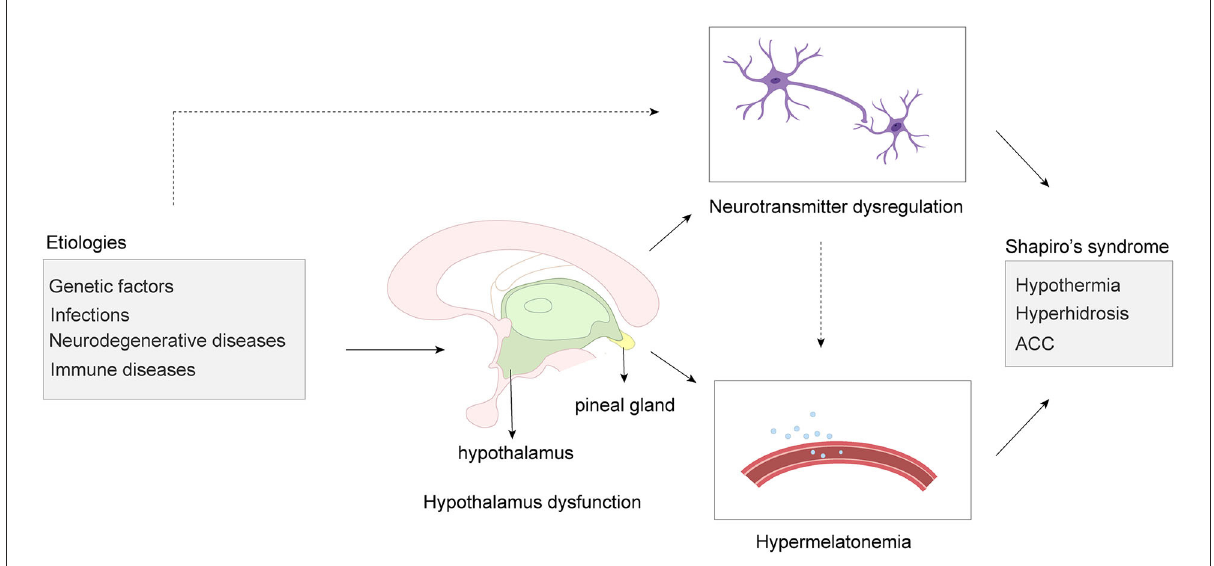
FIGURE1 Schematic illustration of the etiologies and pathological mechanisms of the Shapiro syndrome. The dashed arrows indicate that more evidence may still be needed in this respect. Neurotransmitter dysregulation and hypermelatonemia are collectively referred to as neurochemical abnormalities. ACC, agenesis of the corpus